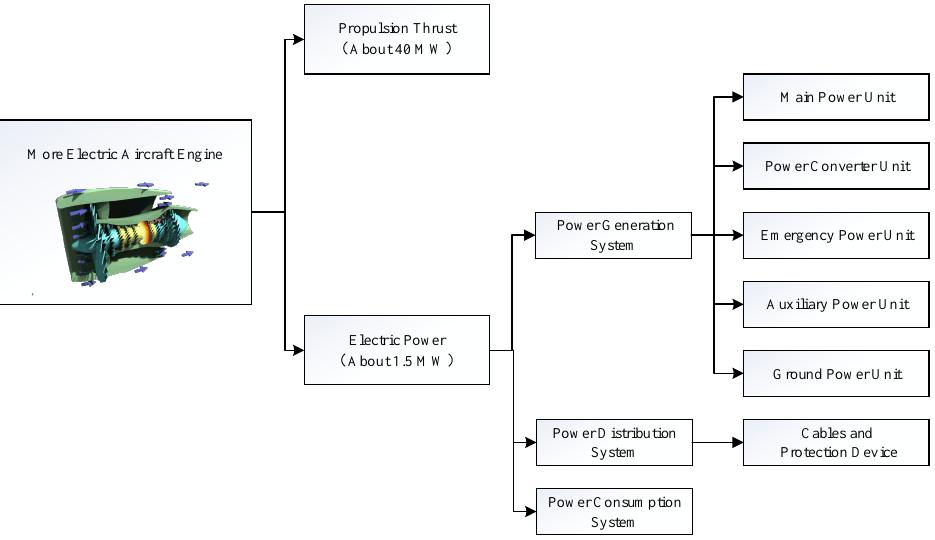
Figure 1. Power system on a more electric